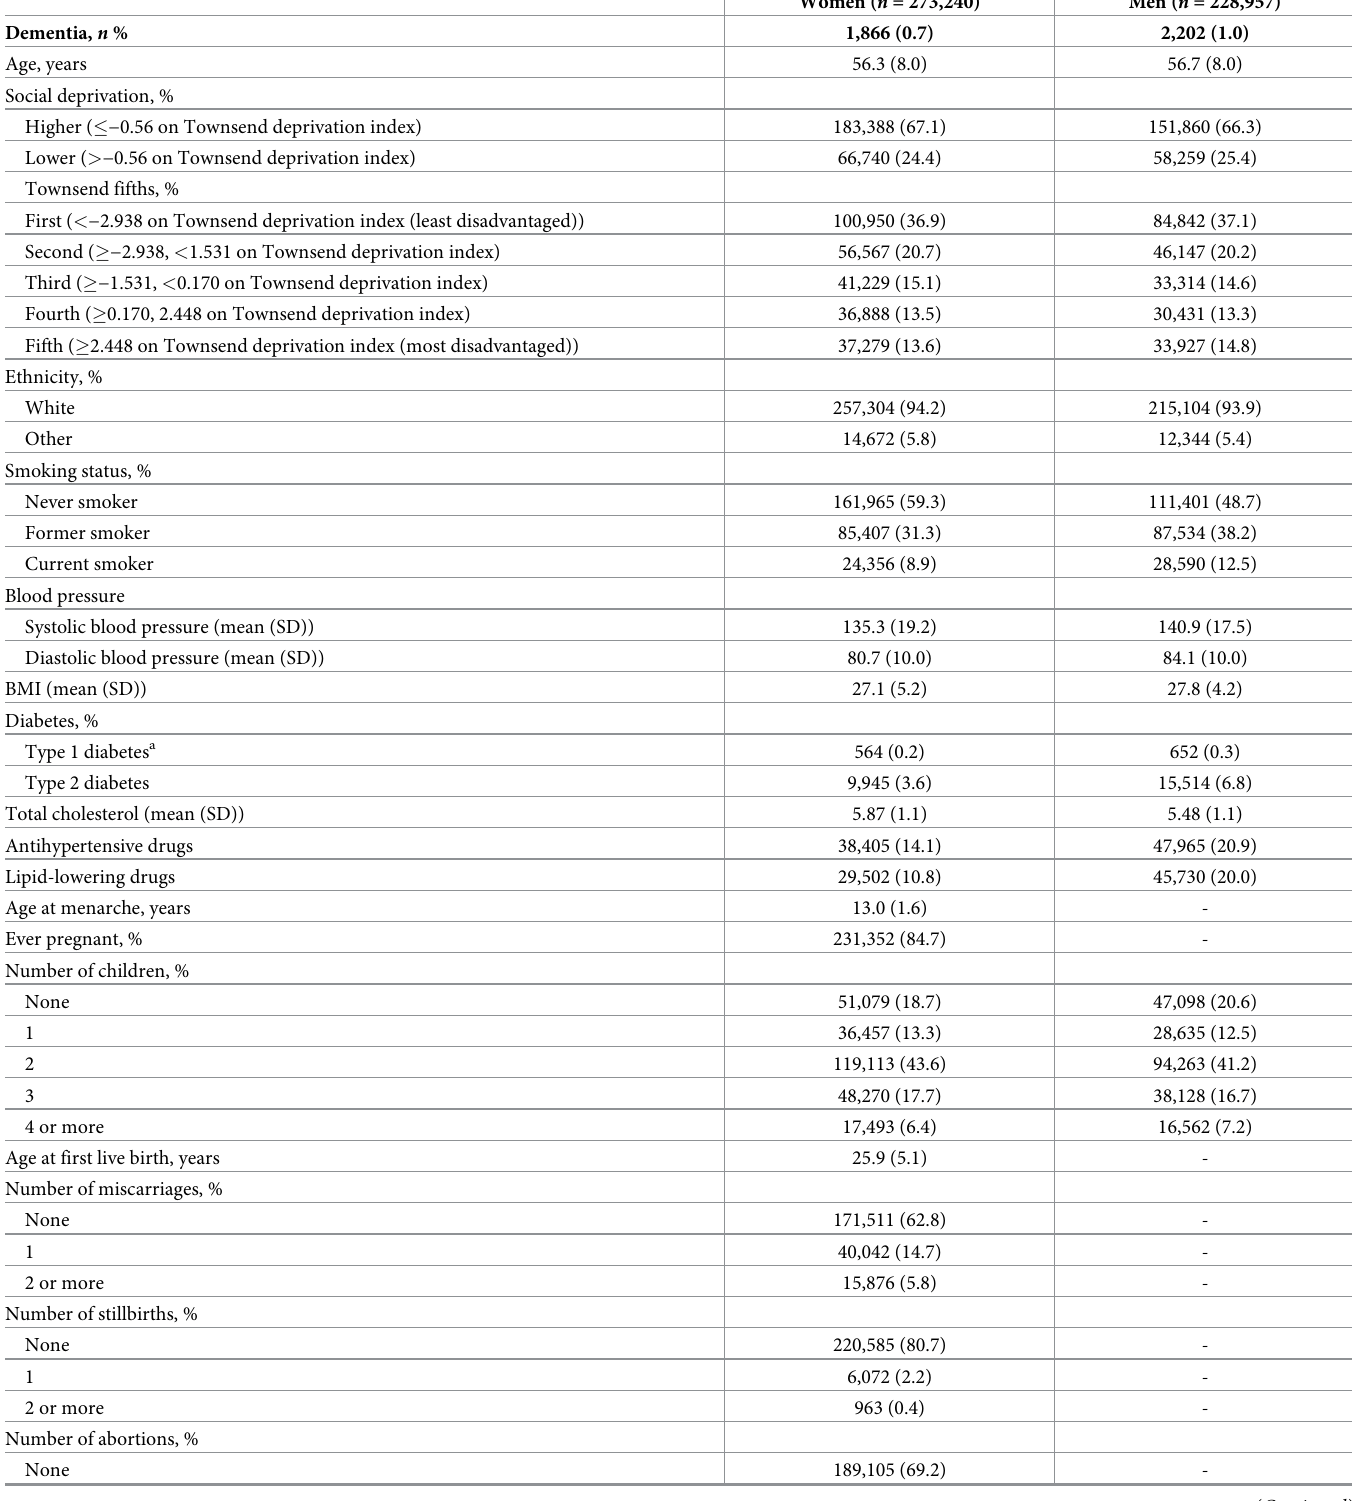
Table 1. Baseline characteristics of study participants in the UK